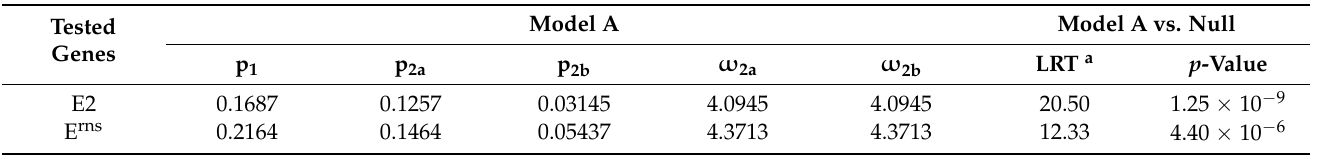
Table 4. The likelihood ratio test results of Model A in PAML for the E2 and E rns genes. Tested Genes